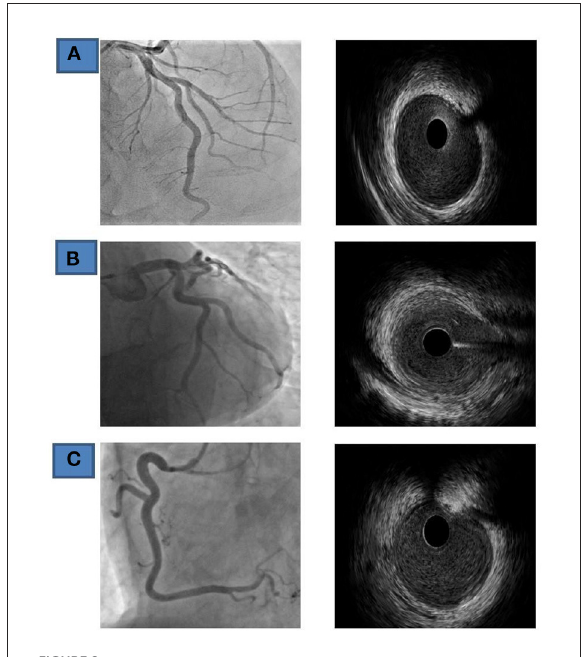
FIGURE2 Coronary findings and IVUS (Fifth day of admission) (A) LAD, left anterior-descending coronary artery. (B) Cx, circumflex coronary artery; (C) RCA- right coronary